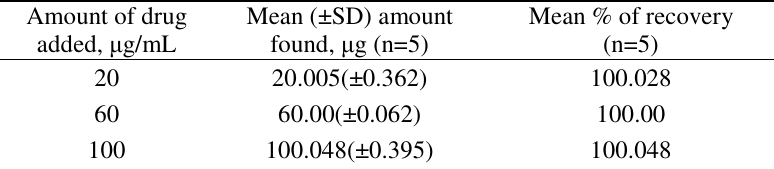
Table 5. Recovery of levetiracetam using proposed HPLC